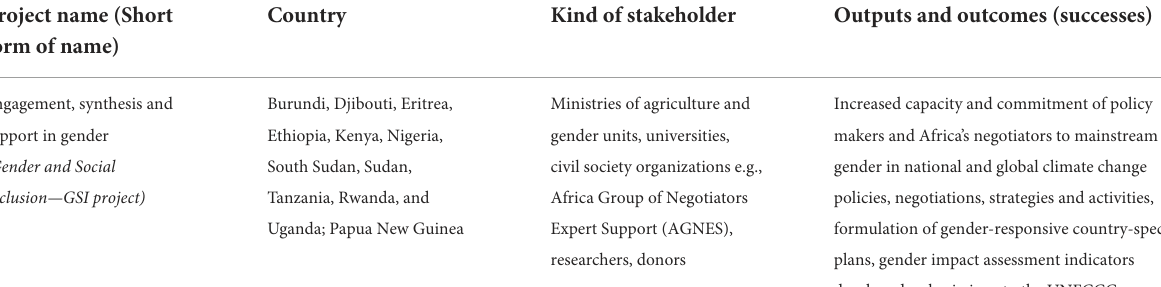
TABLE 2 Summary of CCAFS projects involving gender and climate policy